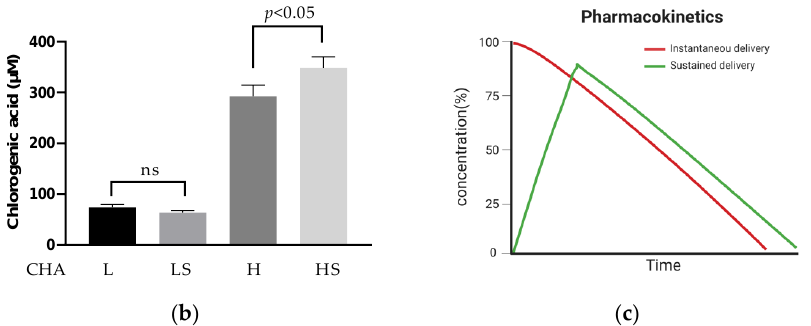
Figure 7. Effect of different delivery models on CHA concentration in the conditioned medium. ( a ) Upper panel: Representative HPLC chromatogram of standard CHA. Middle panel: Representative HPLC chromatogram of the conditioned medium with CHA observed 2 h after starting delivery. Lower panel: Representative HPLC chromatogram of the conditioned medium without CHA. ( b ) The concentration of CHA in the conditioned medium observed 2 h after starting delivery. Statistical analysis was performed using Student’s t -test (L vs. LS; H vs. HS). ( c ) A qualitative model of the